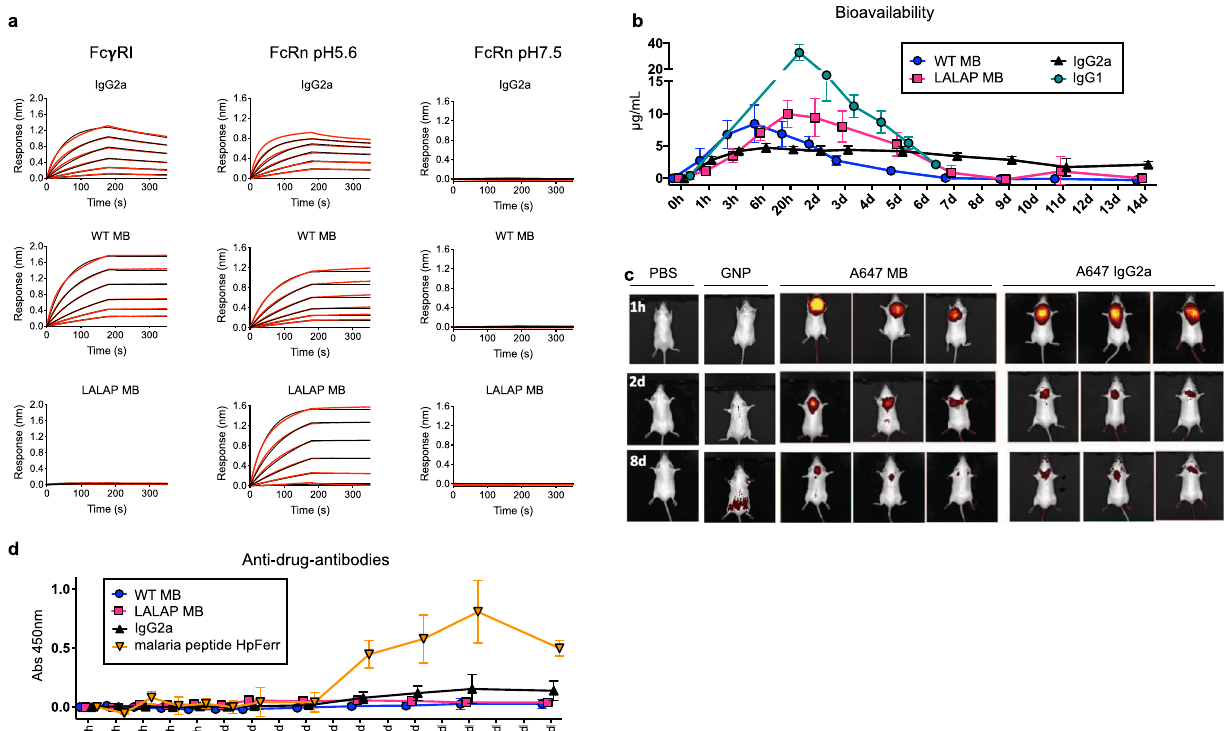
Fig. 2 Bioavailability, biodistribution, and immunogenicity of a mouse surrogate Multabody. a Binding kinetics of WT and Fc-modi fi ed (LALAP mutation) MB to mouse Fc γ RI (left) and mouse FcRn at endosomal (middle) and physiological (right) pH in comparison to the parental IgG. Two-fold dilution series from 100 to 3 nM (IgG) and 10 to 0.3 nM (MB) were used. Red lines represent raw data; black lines represent global fi ts. b Five male C57BL/6 mice per group were used to assess the serum concentration of a surrogate mouse MB, a Fc-modi fi ed MB (LALAP mutation), and parental mouse IgGs (IgG1 and IgG2a subtypes) after subcutaneous administration of 5 mg/kg. c MB and IgG2a samples were labeled with Alexa-647 for visualization of their biodistribution post subcutaneous injection into three male BALB/c mice/group via live noninvasive 2D whole body imaging. 15 nm fl uorescently-labeled gold nanoparticles (GNP), which have a similar Rh value as the Multabody are shown as a comparator. d Five male C57BL/6 mice per group were used to assess any anti-drug-antibody response induced by the mouse surrogate Multabody in comparison to parental IgG and a species-mismatched malaria PfCSP peptide fused to Helicobacter pylori ferritin (HpFerr). Mean values ± SD of n = 5 mice is shown in ( b ) and ( d ). Source data of panels b and d are provided as a Source Data fi